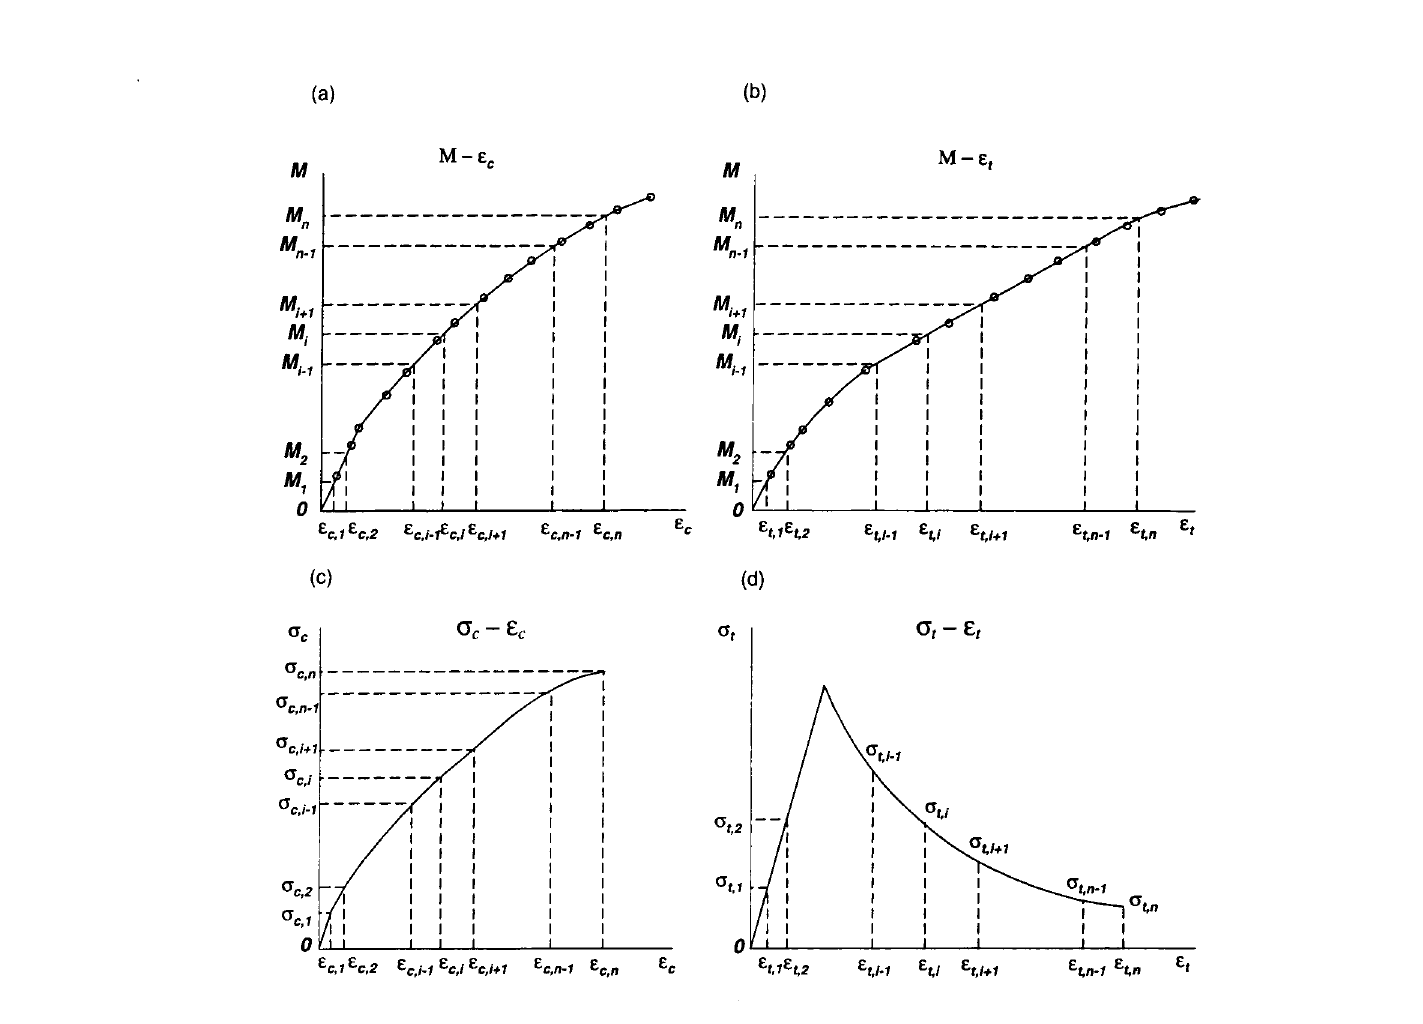
Fig 3. "Experimental" moment-strain curves and computed stress-strain relationships for